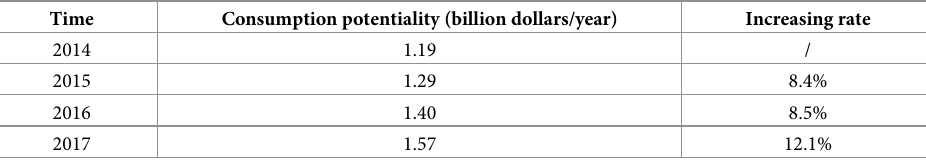
Table 4. Estimation results of consumption potentiality in each year through GWR.